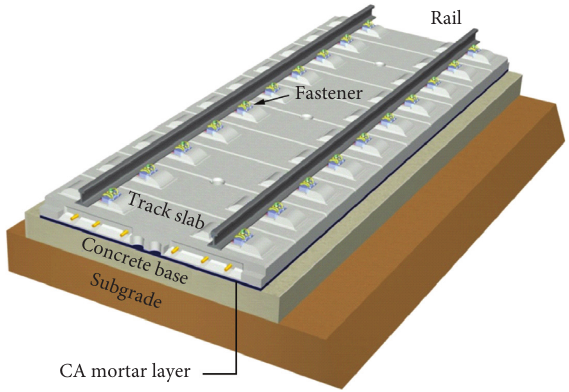
Figure 1: Sketch of CRTS II SBTS.